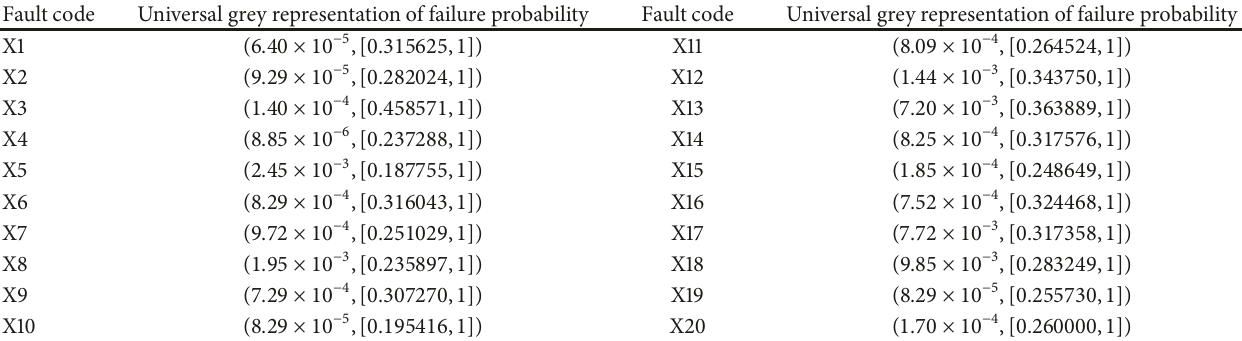
Table 2: Universal grey representation of basic event failure probability for landing gear retraction system fault